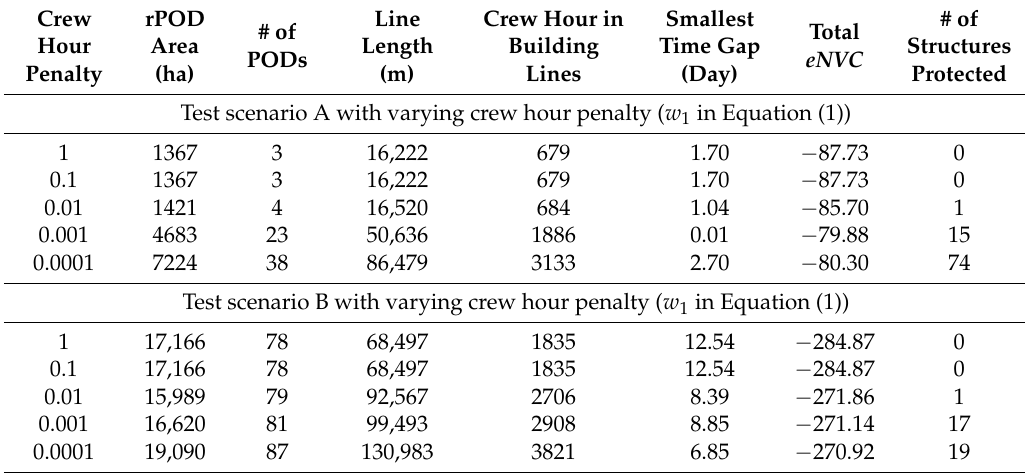
Table 5. Sensitivity analysis varying manager preferences around suppression cost and suppression activity in high flame length